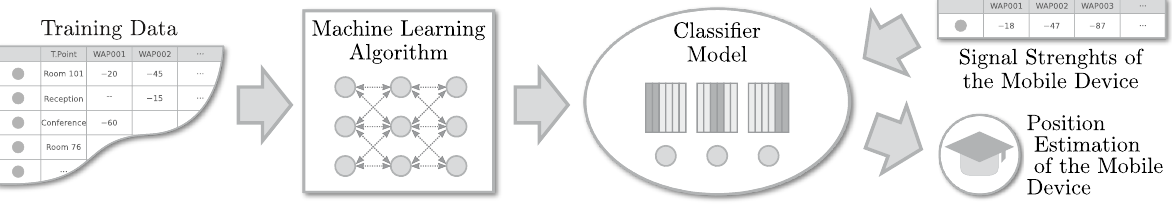
Figure 2. A typical architecture for a fingerprint-based indoor positioning system running on a centralized